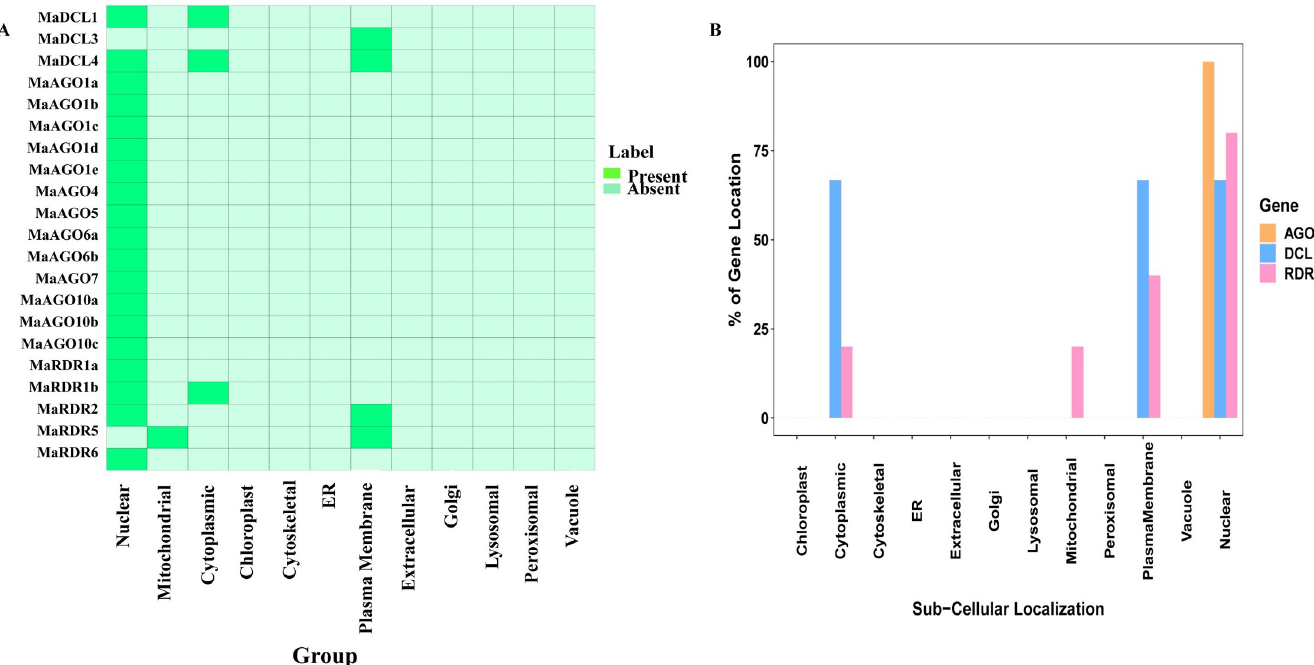
Fig 11. Sub-cellular localization analysis for the (A) MaDCL, MaAGO, and MaRDR proteins. (B) The percentage of protein appeared in different cellular organelles. In this study, predicted proteins were analyzed in Nuclear, Mitochondrial, Cytoplasmic, Chloroplast, Cytoskeletal, Endoplasmic reticulum (ER), Plasma Membrane, Extracellular, Golgi, Lysosomal, Peroxisomal, and